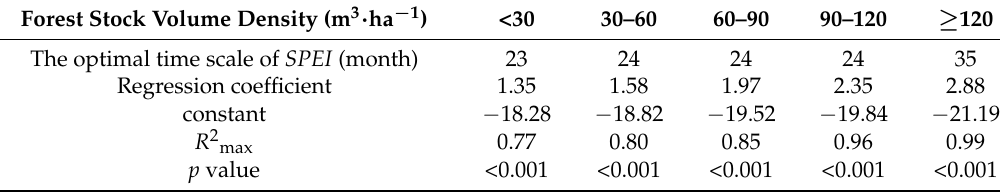
Table 2. Optimal models of SPEI and dEVI for different forest stock volume